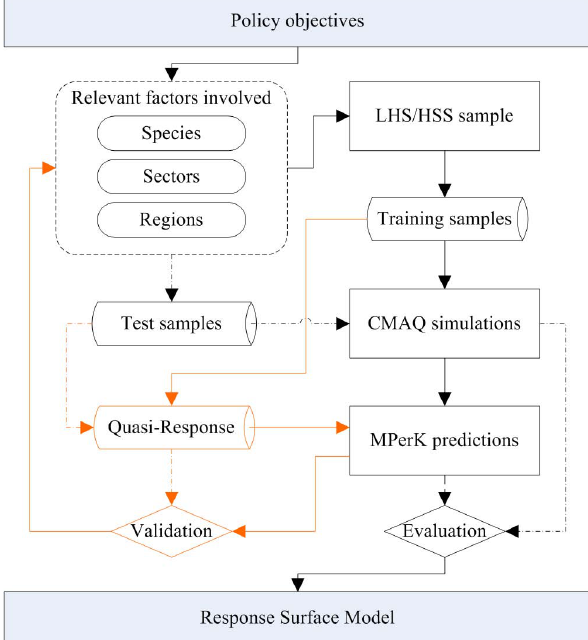
Fig. 1. Key steps in the development of response surface model (Orange lines indicate the preliminary experiment to determine the crucial parameters used to establish RSM; LHS – Latin Hyper- cube Sample; HSS – Hammersley quasi-random Sequence Sample; MPerK – MATLAB Parametric Empirical Kriging